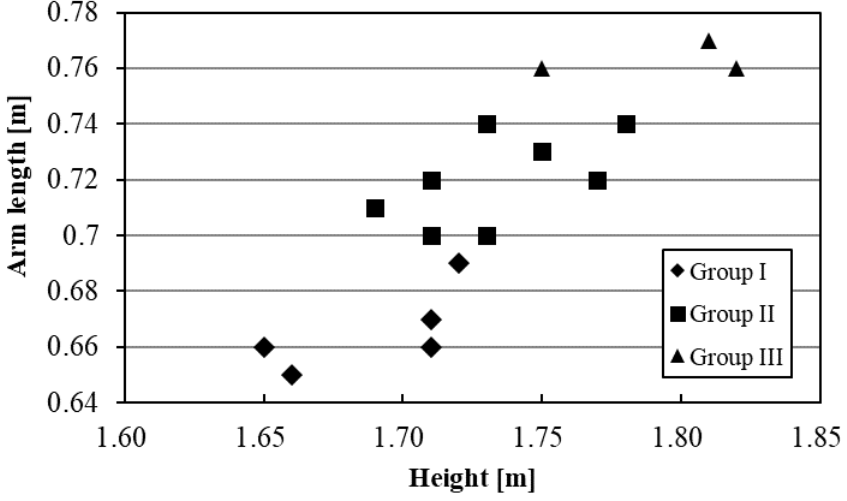
Figure 4. Relationship between height and arm length.